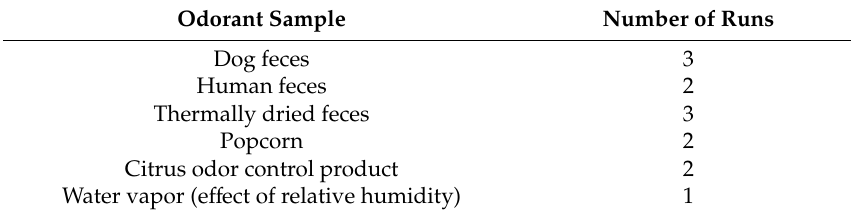
Table 3. Summary of the runs conducted.